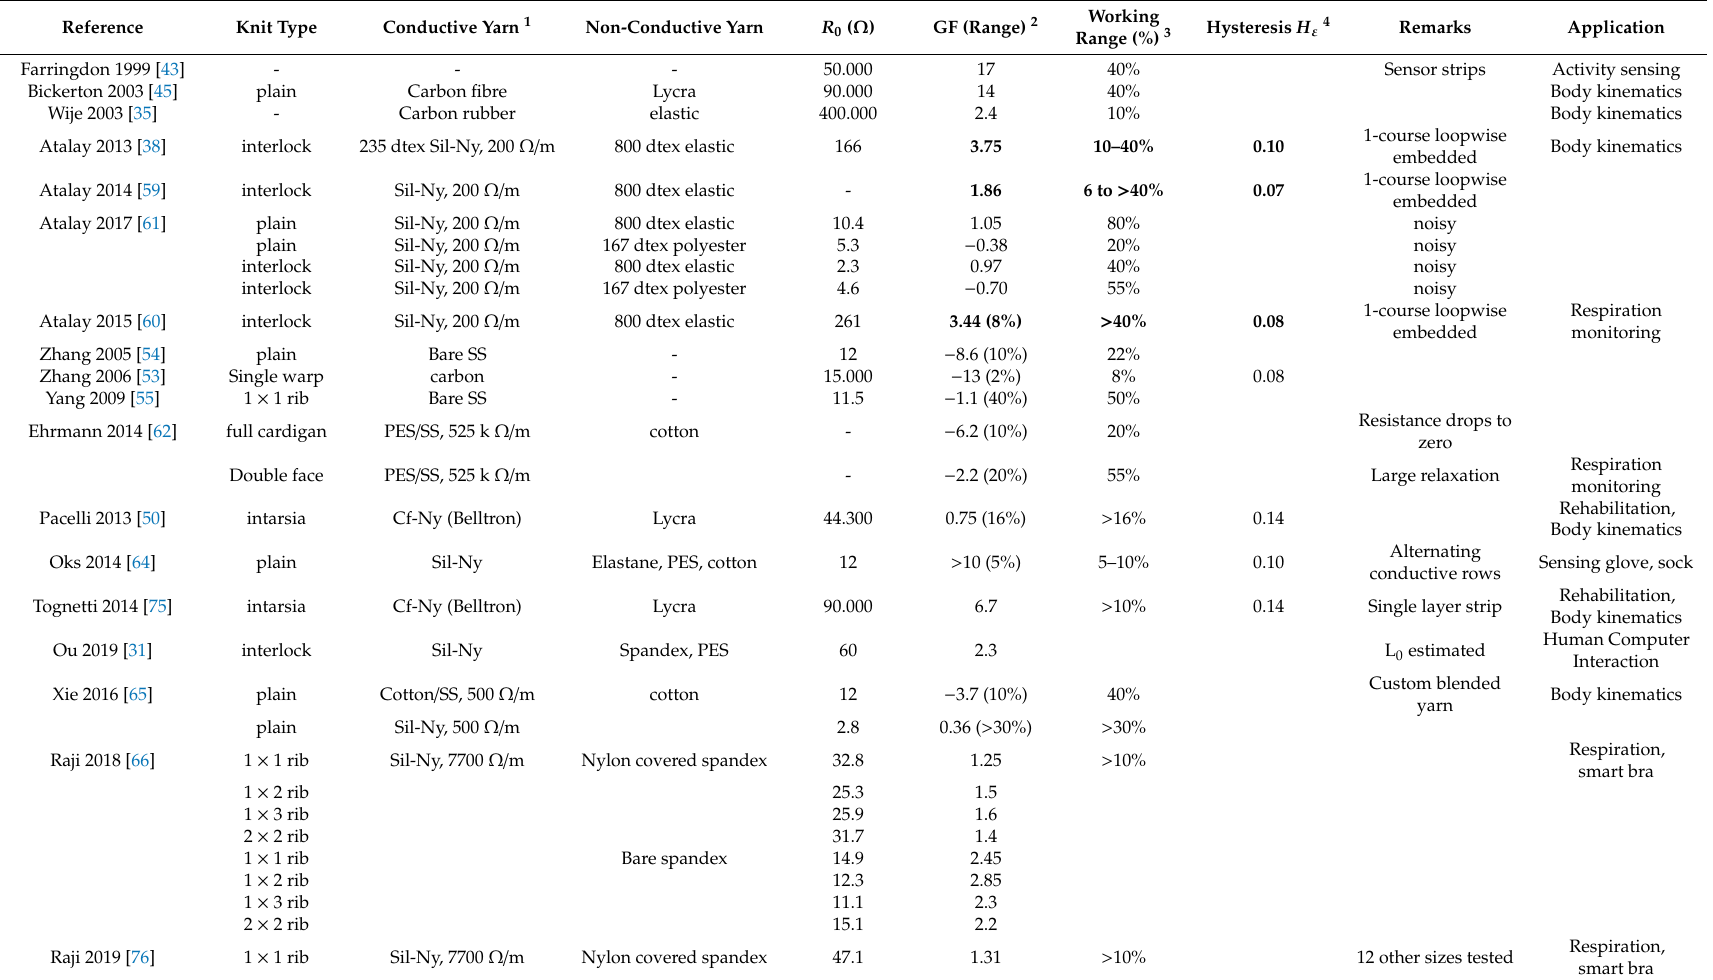
Table 1. Performance comparison of knitted sensors. Sensors with working range above 30% and low hysteresis are